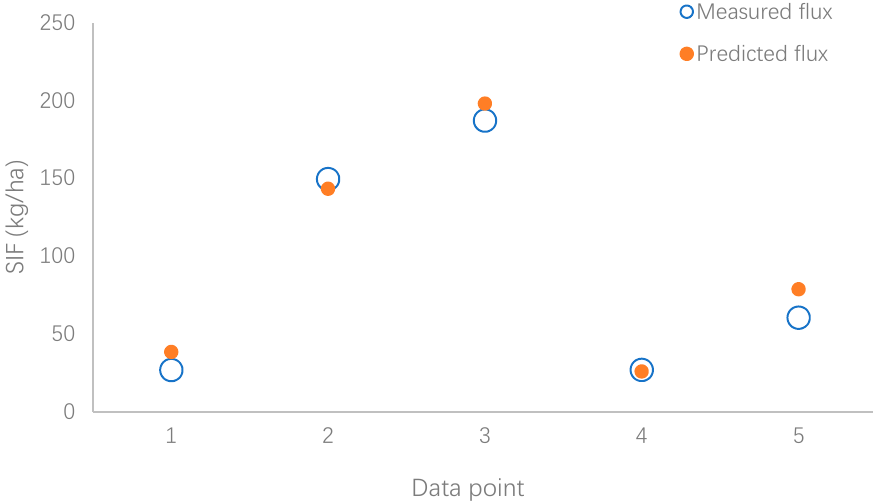
Figure 8. Scatter plot of the actual methane emissions versus the ANN predicted emission.